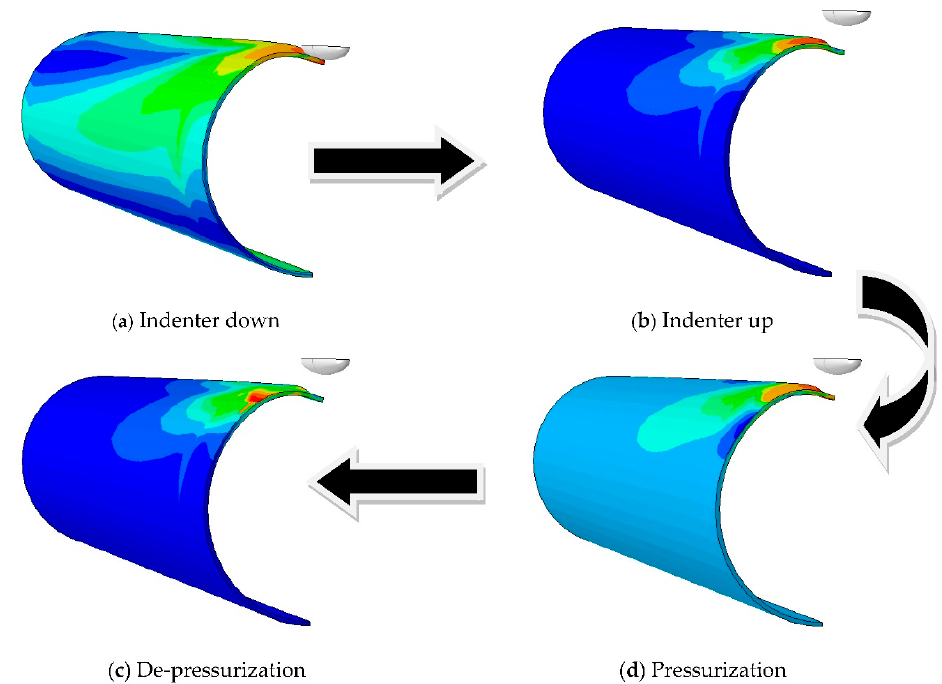
Figure 3. Denting process for the pipe.